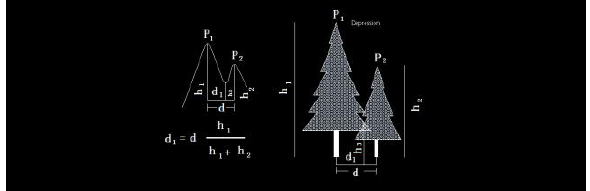
Figure 1. Two adjoined trees and a derived profile that are visualising the concept of the equation